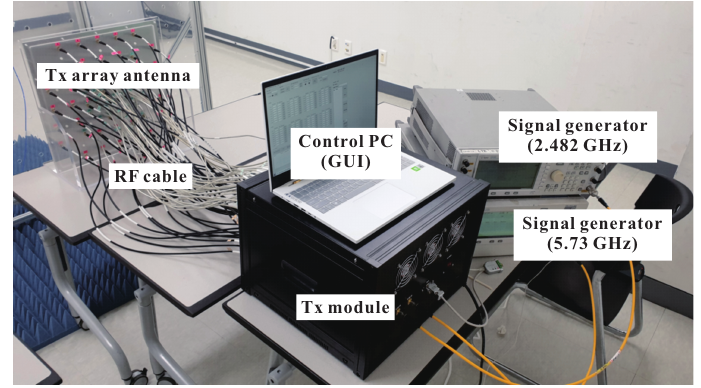
Figure 9. Implemented dual-band Tx